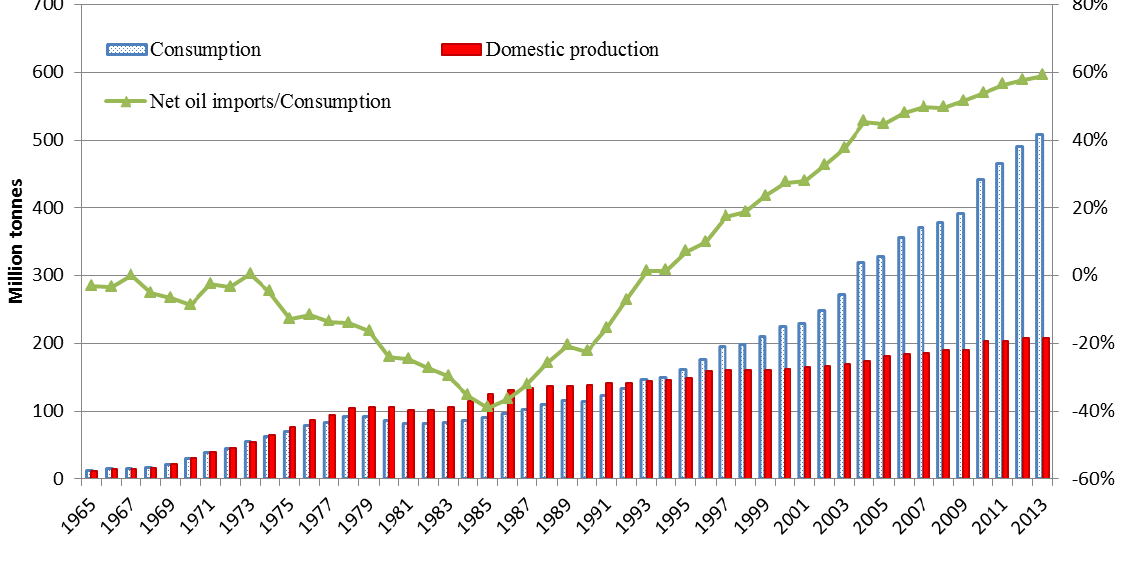
Figure 12. China’s dependence on foreign oil